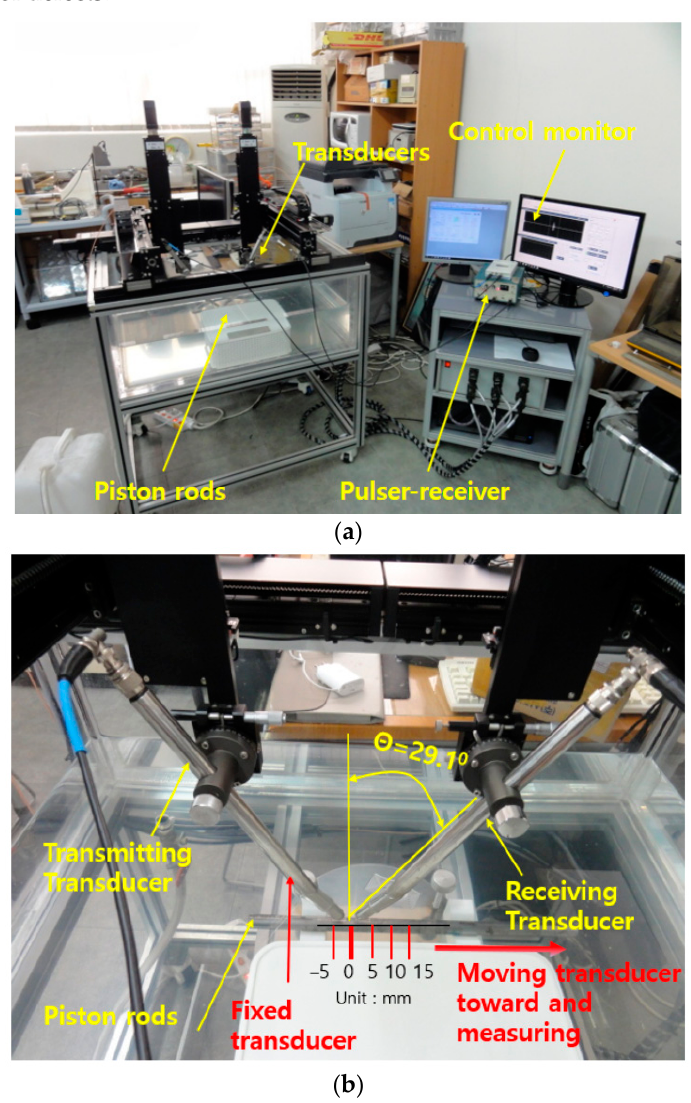
Figure 6. Manufactured UT system used to inspect Rayleigh waves in the immersion tank. ( a ) Ul- trasonic inspection system; ( b ) Ultrasonic setup and measurement.